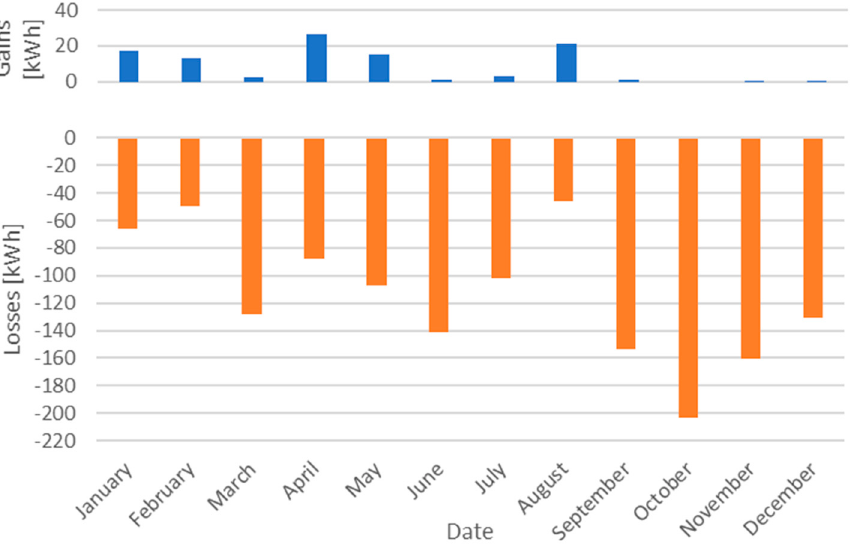
Figure 16. Monthly sum of energy flow between the floor and the ground in variant 4 (stone floor, central heating).